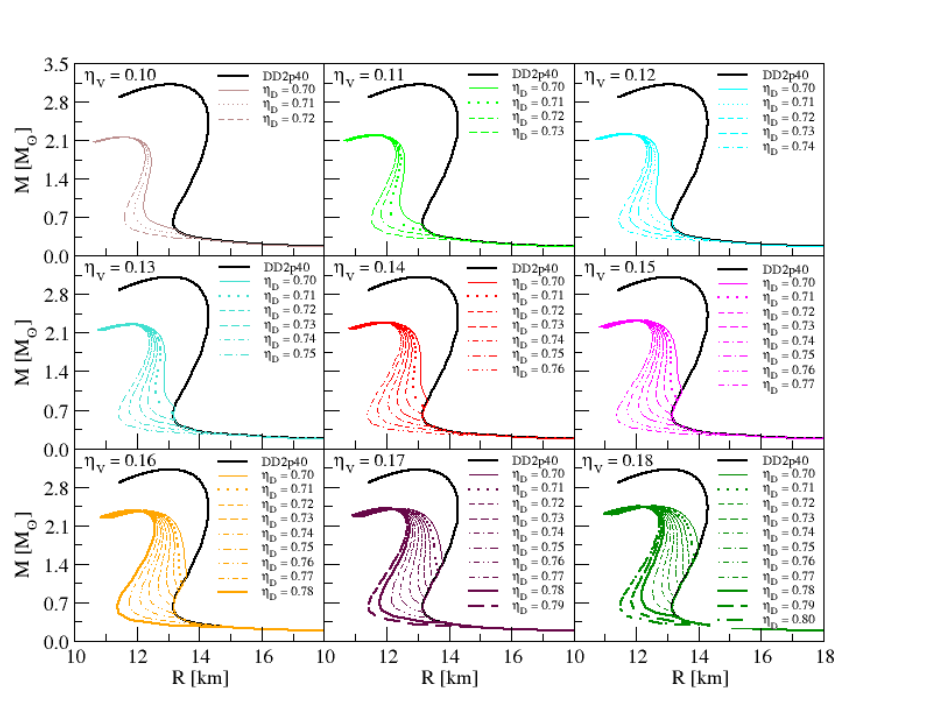
Figure 2. Mass-radius relation for all hybrid stars obtained by a Maxwell construction. The value of η V is taken to be fixed for each panel while the value of η D is